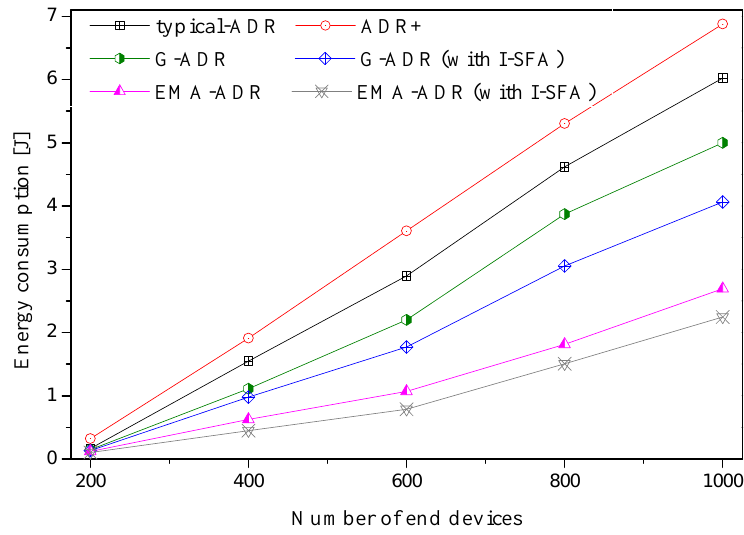
Figure 13. Average energy consumption for mobile EDs (uplink period = 24 packets/day, total simulation time = 4